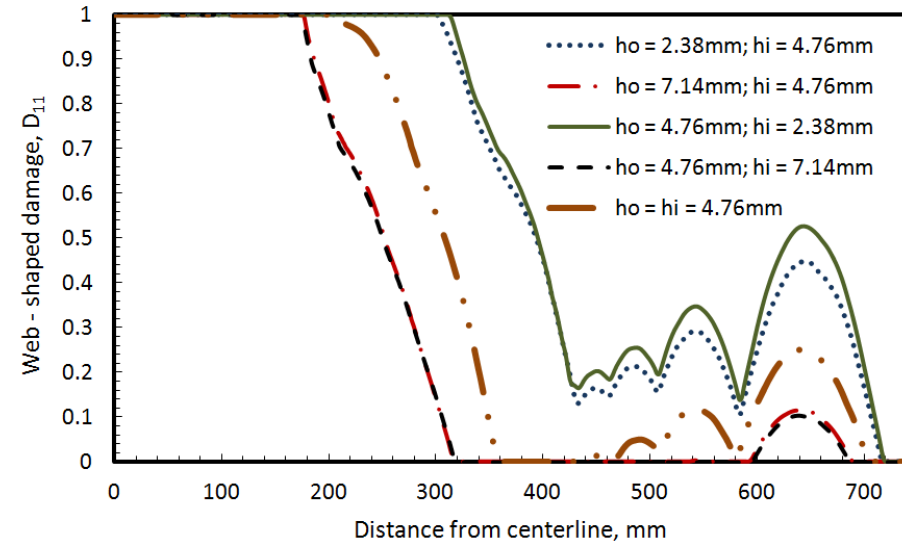
Figure 12. Effect of inner and outer plies thickness on Damage variable D at surface S4 for large missile (round end) impact.